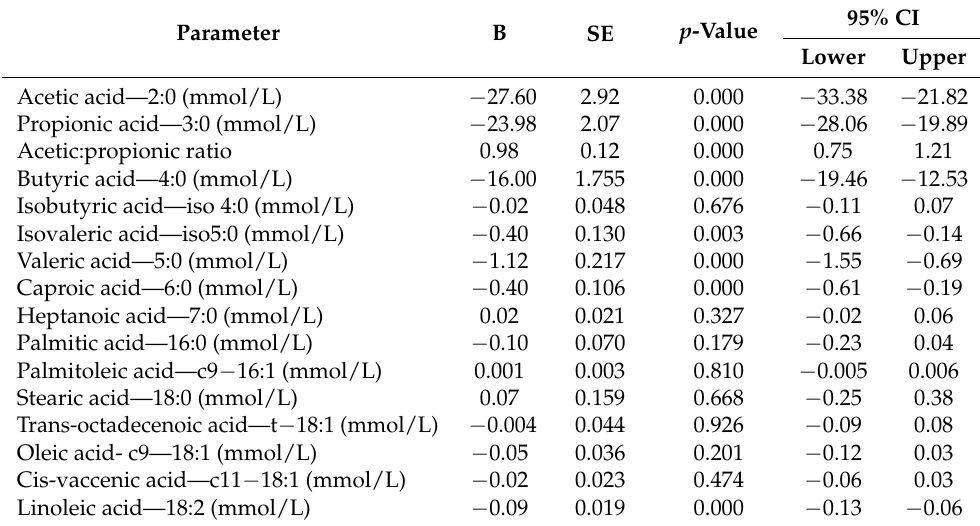
Table 2. Association between ruminal pH values (as continuous variable) and ruminal fatty acids